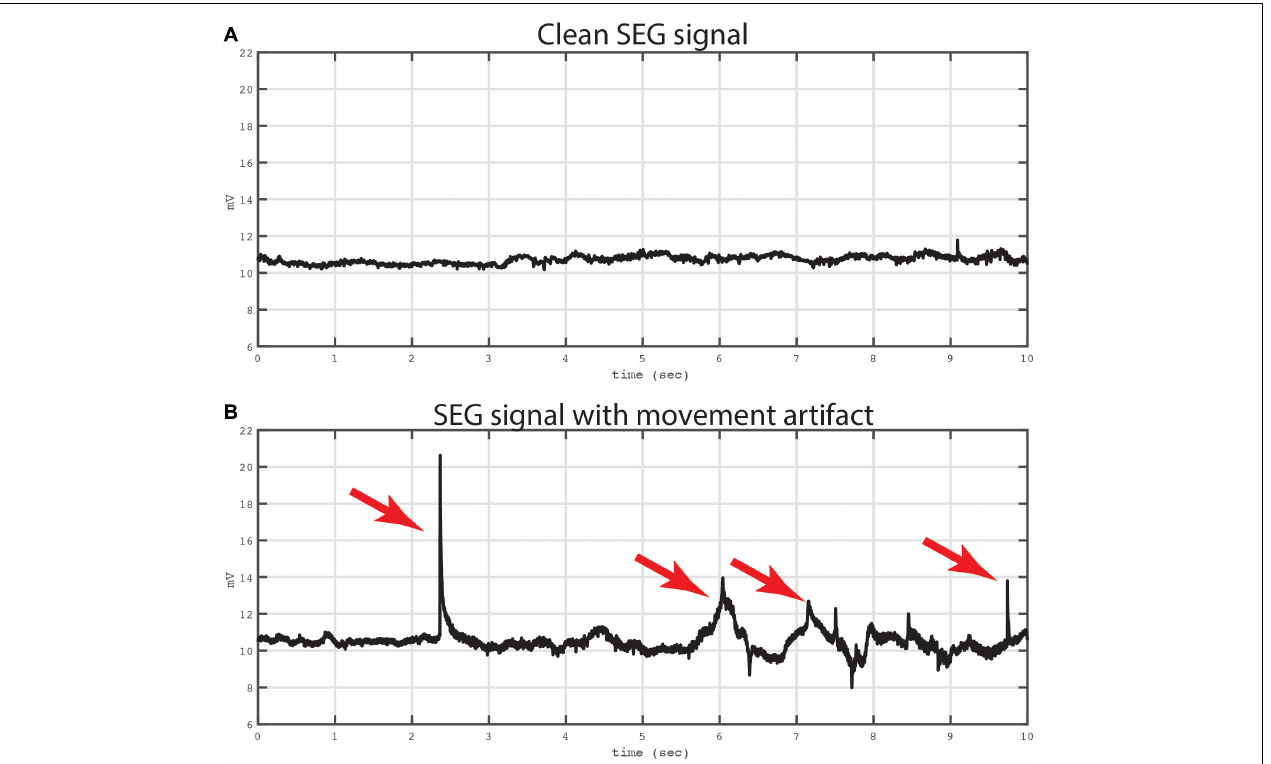
FIGURE 6 | Example of bipolar recordings with and without artifact. Two traces from a bipolar recording are shown. Both traces were recording from a bipolar signal derived from electrodes in the cervical spine. The top trace (A) shows a 10 s period that is not contaminated by movement artifact. The Kurtosis value for this tracing was 2.29. The bottom trace (B) shows the same bipolar signal at later time window with mechanical artifact contaminating the signal. The artifact was evoked by mechanical manipulation of the leads and connector device relative to the patient. Artifacts are labeled with red arrows. The Kurtosis value for this tracing was